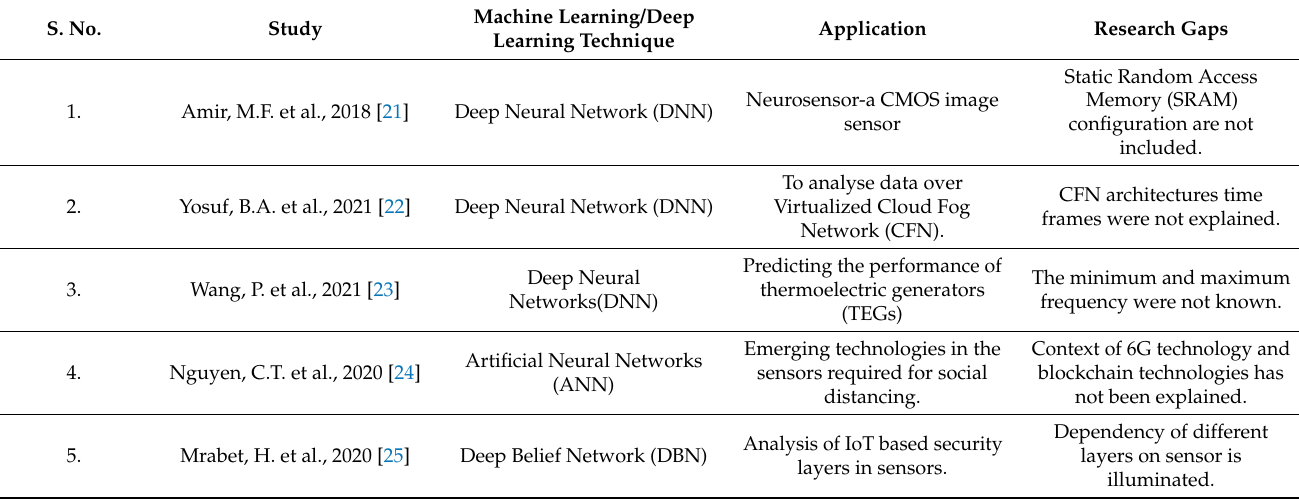
Table 1. Energy consumption protocol in wireless body area